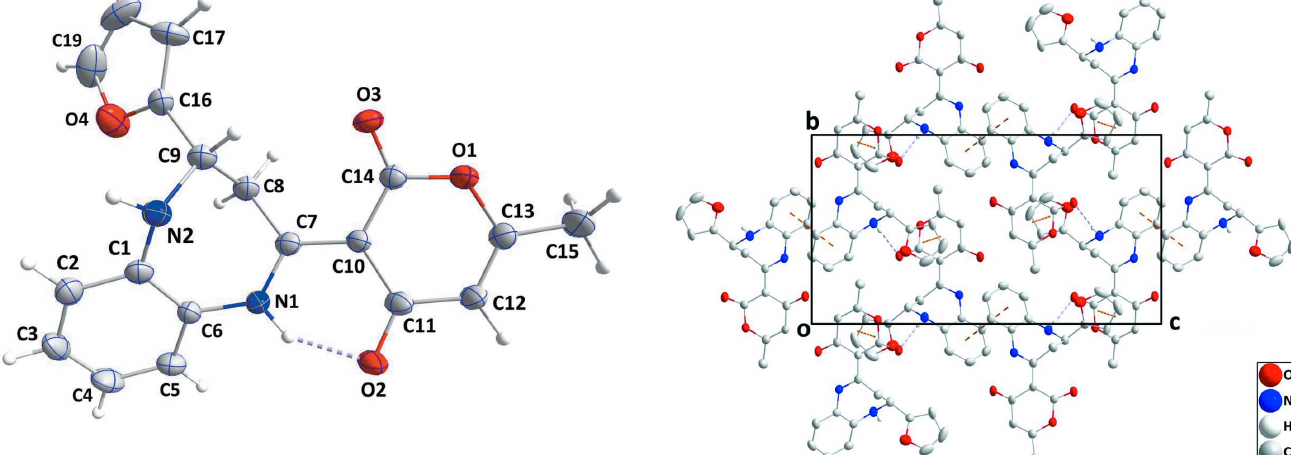
Figure 1 The molecule of (I) with the atom-numbering scheme and displacement ellipsoids drawn at the 50% probability level. The intramolecular hydrogen bond is depicted by a dashed